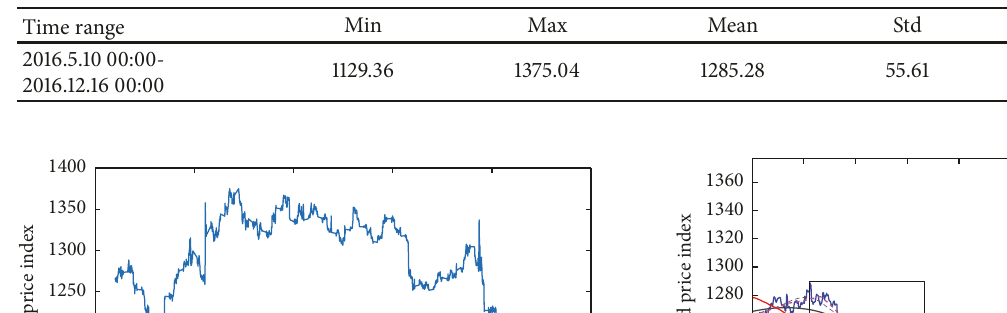
Figure 1: Moving 𝑉 𝑛 (𝑡,𝑠) -statistic analysis process. Table 1: Descriptive statistic for volatilities of XAU/USD.